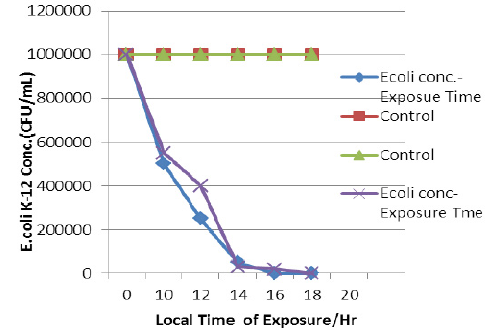
Figure 10. Inactivation of bacteria Ecoli K-12 in drinking water exposed to solar irradiation. Adapted from EU Contract Number INCO-DEV 031650 (2006)